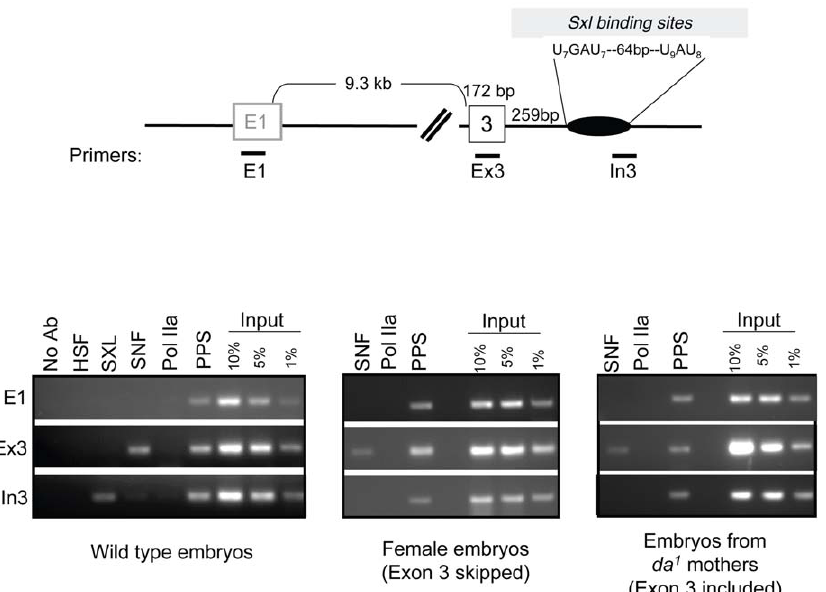
Figure 6. Accumulation of SXL, SNF, and PPS along the body of the Sxl gene in embryos. ChIP using SXL, SNF, and PPS specific antibodies. After ChIP, the extracted DNA was analyzed by PCR using primer pairs positioned along the Sxl gene as diagramed. Specificity controls include ChIPs using antibodies directed against the Heat Shock Factor (HSF) and RNA Pol IIa (8WG16), as a well as a no antibody control (no Ab). ChIPs were carried out, from left to right, in 8–12 hour old wild-type embryos, female embryos (embryos from C(1)DX mothers crossed to Sxl 7BO males) and embryos from da 1 /da 1 mothers. To ensure that the PCR reactions of the antibody enriched DNA fell within a linear range of amplification, PCR reactions were carried out on serially diluted input DNA, ranging from 1% to 10% of total DNA. The PCR data shown here are representative of three independent ChIP experiments.